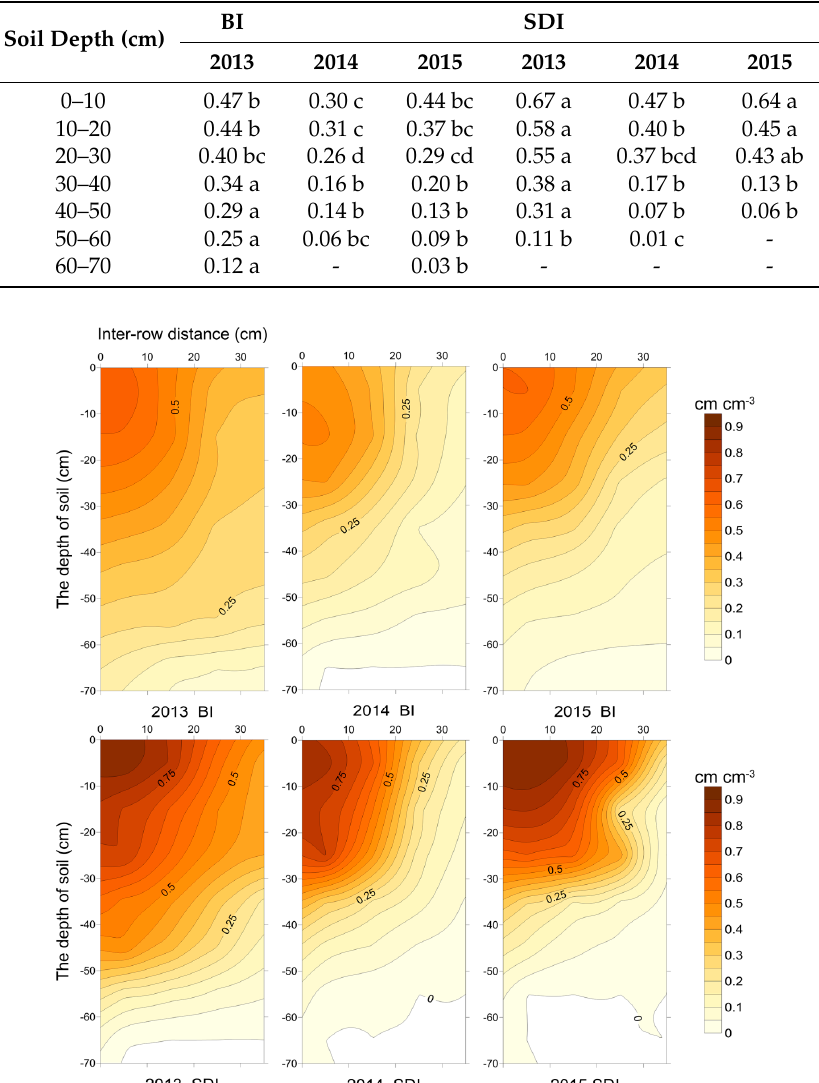
Figure 6. Two-dimensional RLD of transplanted cotton. Abbreviations: BI, border irrigation; SDI, surface drip irrigation; and RLD, root length density.